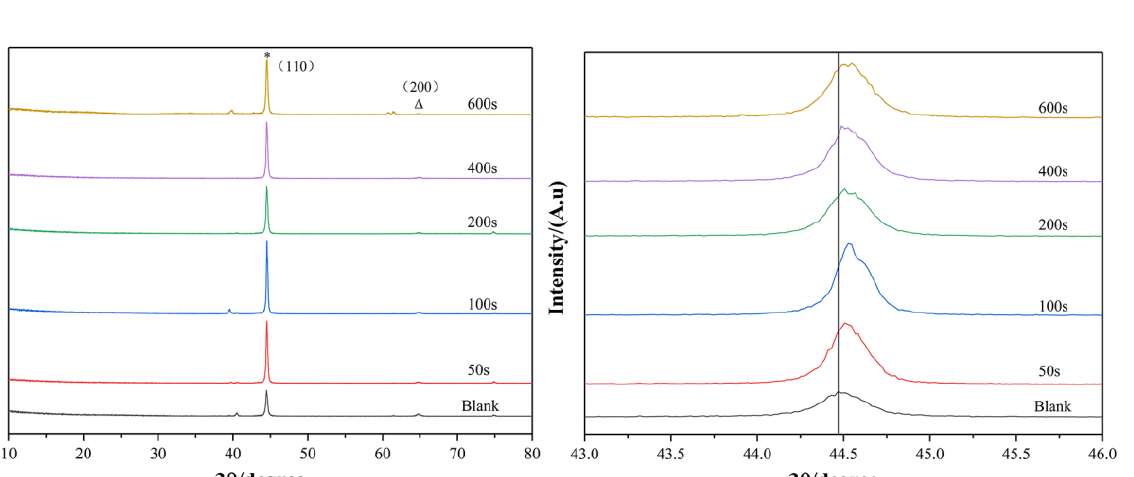
Figure 6. XRD patterns and enlarged images of samples with different shot peening times.